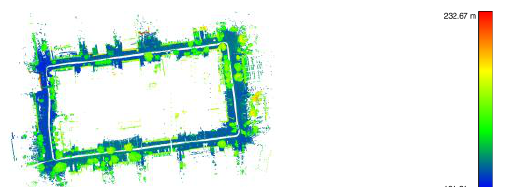
Figure 2 . LiDAR data used for evaluation (color-coded by height